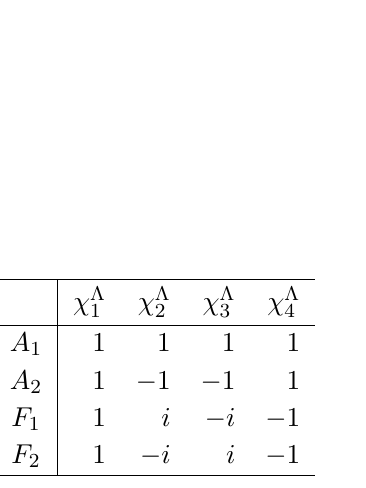
Table 20. Characters χ Λ for the single-valued and double-valued irreducible representations Λ of the group C s . χ Λ denotes the character of Λ for all group elements in class C n . See table 19 for the n definitions of the classes C n . Since all of the representations are one dimensional, the characters are the representation